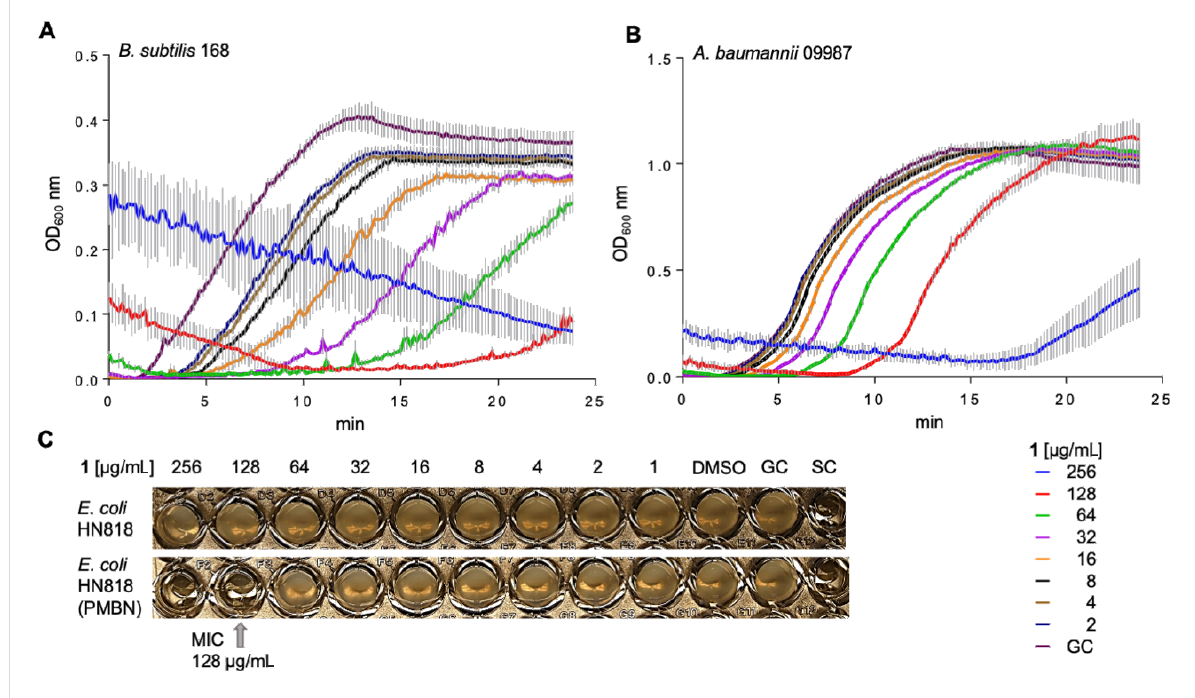
Figure 3: Bioactivity testing with hangtaimycin ( 1 ). A) Growth retardation of model species B. subtilis 168 and of B) nosocomial pathogen A. baumannii 09987 monitored by recording the turbidity increase of growing culture aliquots exposed to a concentration series of 1 every 10 min over 24 h. An increase in the optical density at 600 nm (OD 600 ) reflects biomass production. At concentrations of ≥ 64 µg/mL 1 precipitated, leading to elevated OD 600 values at the beginning of the experiment that were unrelated to growth. The curves reflect the mean values of three separate cultures and standard deviations are depicted by black bars. C) MIC assay against E. coli . The MIC is defined as the lowest concentration of an anti- bacterial agent inhibiting visible bacterial growth (no turbidity detected by the naked eye) after overnight incubation. Only when the outer membrane was permeabilised by polymyxin B nonapeptide (PMBN), 1 inhibited growth of E. coli sufficiently to yield a clear MIC. GC, growth control (no inhibitor), SC, sterile control (no bacteria), DMSO, culture medium supplemented with 1% DMSO, reflecting the DMSO concentrations in the hangtaimycin-con- taining samples.